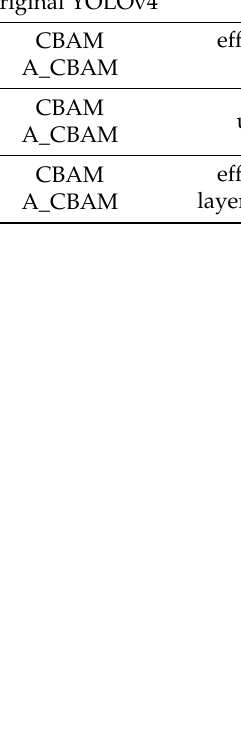
Table 5. Comparison of the performance of different object detection